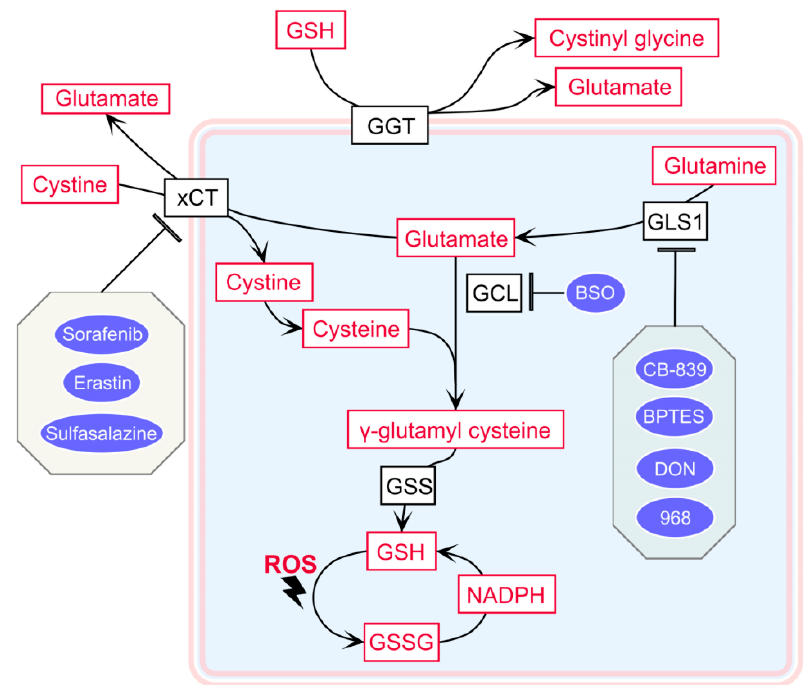
Figure 1. Schematic overview of glutathione (GSH) metabolism and the targeting sites of inhibitors. Color codes are defined as follows: black = enzymes or transporters; red = metabolites; blue = inhibitors. GGT: γ -glutamyl transferase; xCT: solute carrier family 7 member 11, a cystine-glutamate antiporter; GLS1: glutaminase 1; GCL: glutamate cysteine ligase; GSS: glutathione synthetase. GSSG: glutathione oxidized form; ROS: reactive oxygen species.